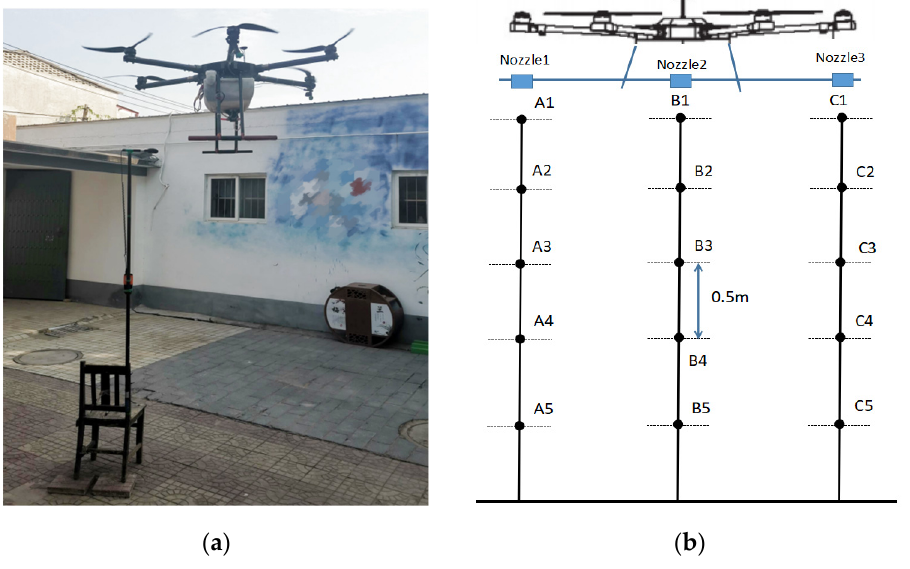
Figure 12. ( a ) wind speed test site; ( b ) measurement point layout. Table 3. Experimental and simulated values of z-direction velocity of measurement points. Measurement Point Serial